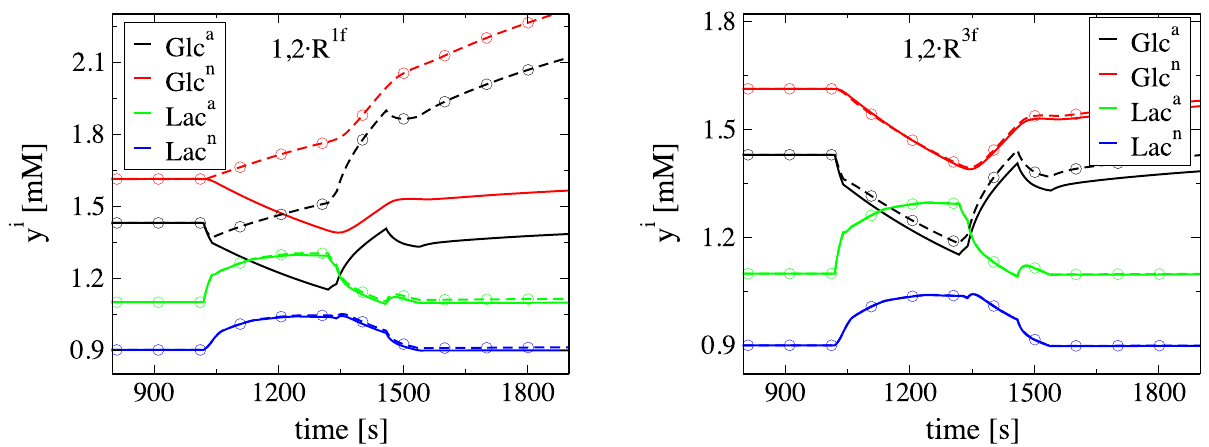
Fig 7. Response of Glc a , n and Lac a , n in increase of R 1 f and R 3 f . Evolution of Glc a , n and Lac a , n during neuronal activation. Comparison of the solution under normal conditions (solid lines) with the one under perturbed rates conditions (dashed lines with circles). Left: Increase of R 1 f by 20%, Right: Increase of R 3 f by 20%.